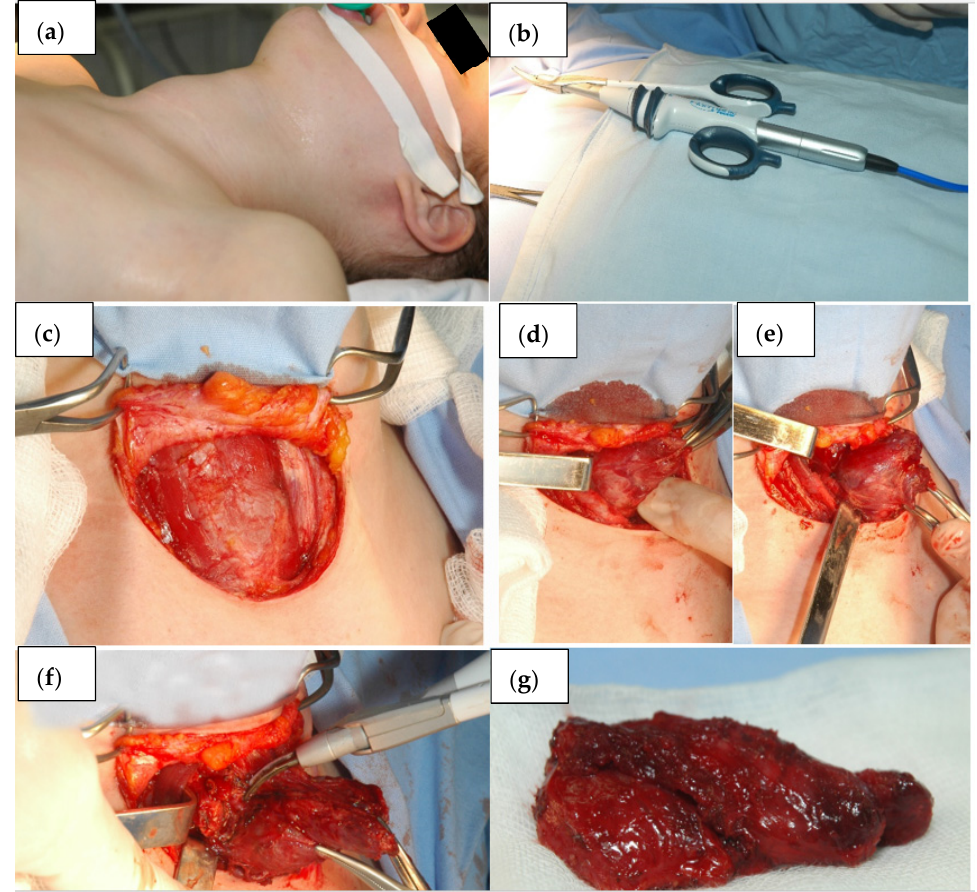
Figure 2. Thyroid lobectomy with isthmusectomy. ( a )—Patient before the operation, ( b )—ultrasonic surgical device, ( c )—upper and lower skin flap is formed under the platysma, ( d , e )—mobilisation of the thyroid gland, ( f )—ligation and resection of the thyroid artery, ( g )—thyroid lobe with isthmus.